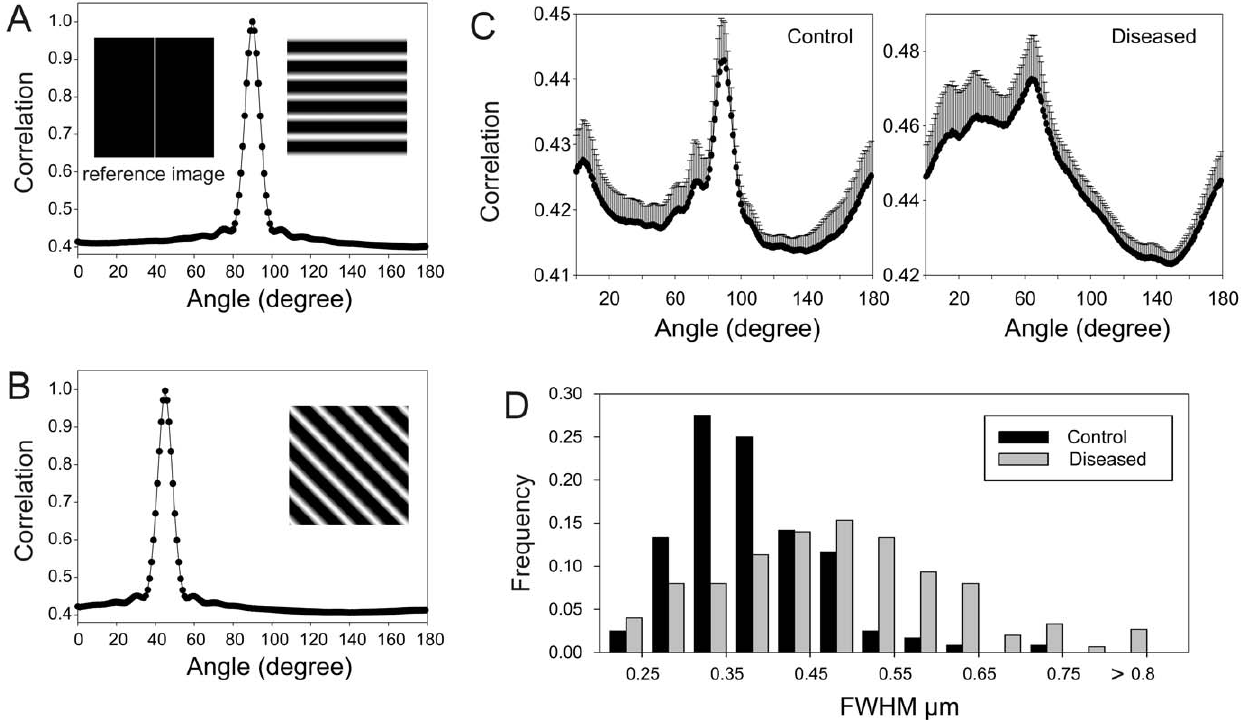
Figure 3. Analysis of changes in ventricular myocyte t-tubule geometry in human heart failure. Correlation analysis of t-tubule angle: To illustrate the analysis, two model t-tubule images were created and correlated to the reference image, one with tubules running at 90 u angle (panel A ) and the other with tubules running at 45 u angle (panel B ), demonstrating that the angle with peak correlation intensity matches the direction of tubules in the model images. ( C ) Correlation analysis of longitudinal sections to measure t-tubule orientation referred to the cell surface. Analyses of normal cells are shown in the left panel and diseased tissue are shown on the right. Note the change in predominant tubule angle and increased spread of t-tubule angles in the diseased tissue. ( D ) Full width at half maximum (FWHM) measurements of control and diseased tubules corrected for optical blurring. In normal myocytes, tubule widths are smaller and have a narrower size distribution compared to diseased myocytes (p=0.0003 see